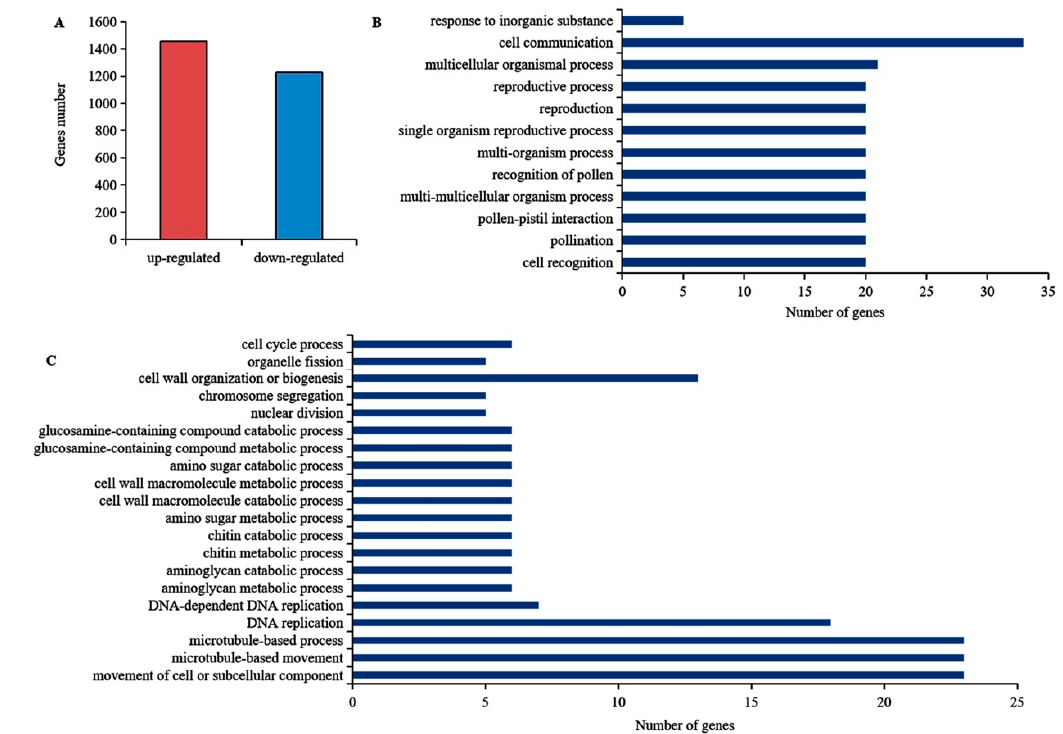
Figure 3. Comparisons and biological process GO enrichment of DEGs between WT and dwf . ( A ) Numbers of up-regulated and down-regulated DEGs. ( B ) Up-regulated DEGs enriched in thirteen significant BP pathways. ( C ) Down-regulated DEGs enriched in the top twenty significant BP pathways.